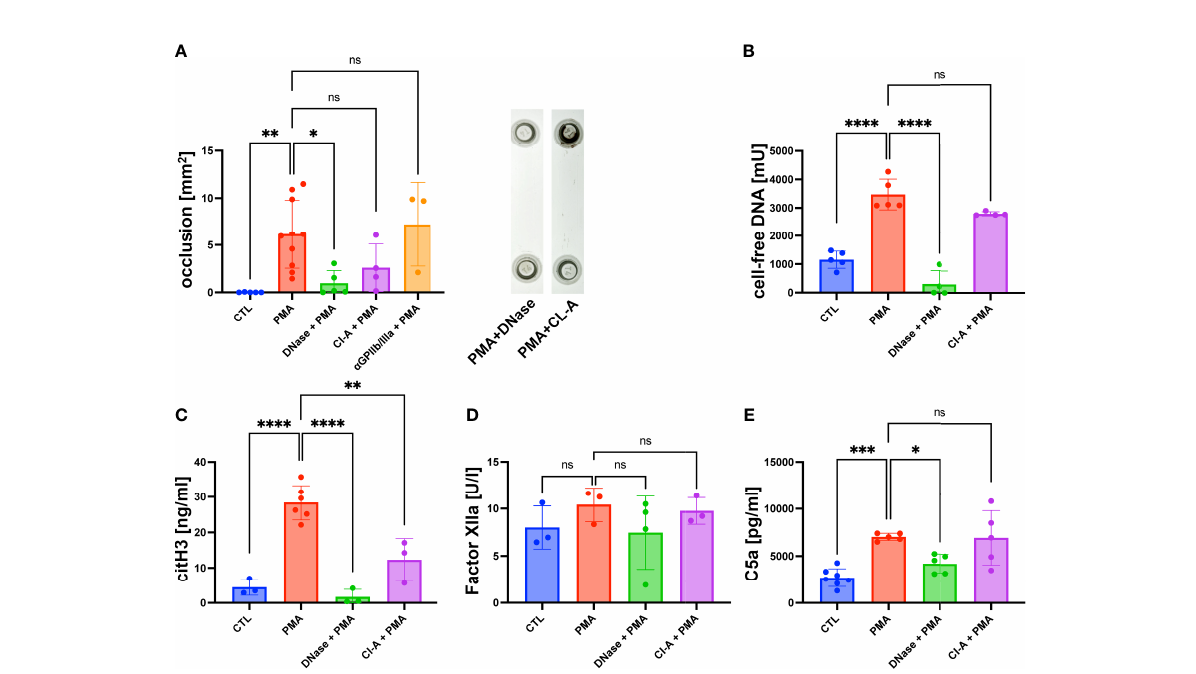
FIGURE 2 PMA induced channel occlusion and effects of DNA degradation and NETosis inhibition in hirudinated whole blood. (A) Quantitative analysis of the channel occlusion is shown as bar diagram. To prove the impact of extracellular DNA and NETosis on occlusion, DNase I or Cl-A was added. Representative photographs of fl uidic slides, after treatment with DNase I or CL-A are shown. (B) Plasmatic cell-free DNA was increased in PMA-treated slides in comparison to CTL slides. Amount of cell-free DNA was reduced by DNase I and Cl-A treatment. (C) CitH3 was increased in PMA-treated slides in comparison to CTL slides. Less plasmatic citH3 was measured upon DNase I or Cl-A treatment. (D) Plasmatic levels of factor XIIa were neither affected by PMA stimulation nor DNase I or Cl-A treatment. (E) C5a was signi fi cantly increased in PMA-treated slides in comparison to CTL slides. PMA-induced C5a levels were signi fi cantly decreased upon DNase I treatment. Data are shown as mean ± SD, scatter plots indicate the number of independent experiments, *p<0.05, p**<0.01, ***p<0.0005, ****p<0.0001, ns = not signi fi cant, one- way ANOVA with Tukey post hoc